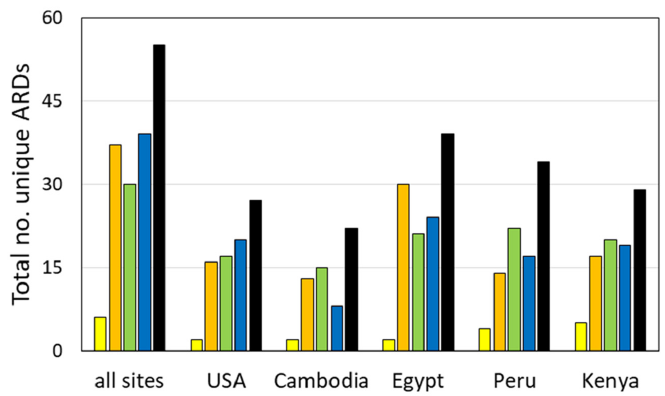
Figure 2. Numbers of unique ARDs observed for Campylobacter spp. (yellow), E. coli (orange), Shigella spp. (green), Salmonella (blue), and all species (black) detected in isolates from each collection site. Table 2. ARDs detected in Campylobacter spp. by geographic location (percent of isolates positive).